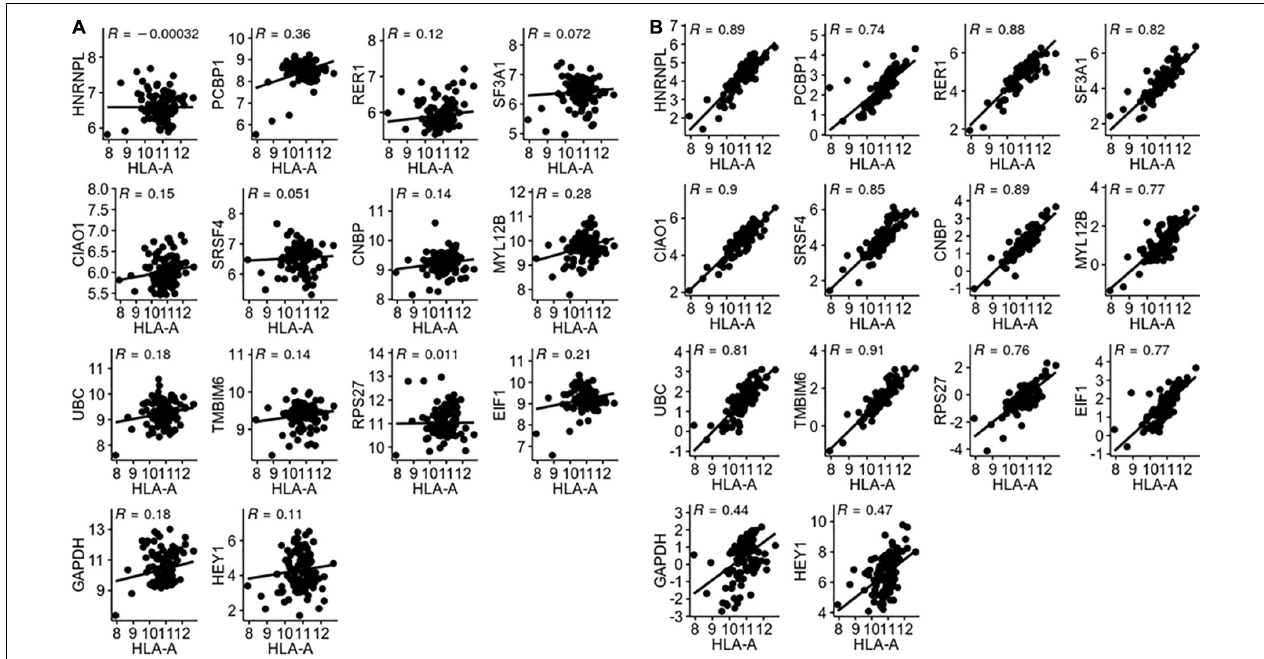
FIGURE 2 | (A) Correlation between HLA-A and reference gene expression. (B) Correlation between pre- and post-normalized HLA-A gene expression.